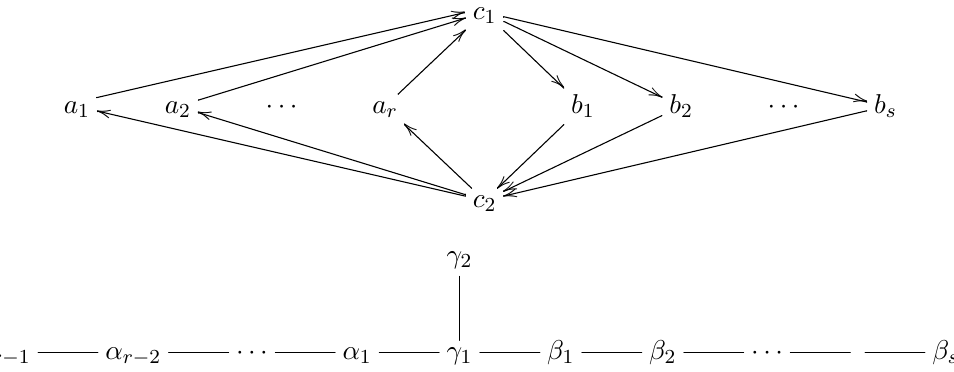
Figure 2. The Q ( r; s ) (cid:17) Q ( s; r ) quiver ( r + s ) > 0. The corresponding N = 2 theory has one- dimensional Coulomb branch and rank ( r + s ) (cid:13)avor symmetry group G F with the Dynkin graph in the lower